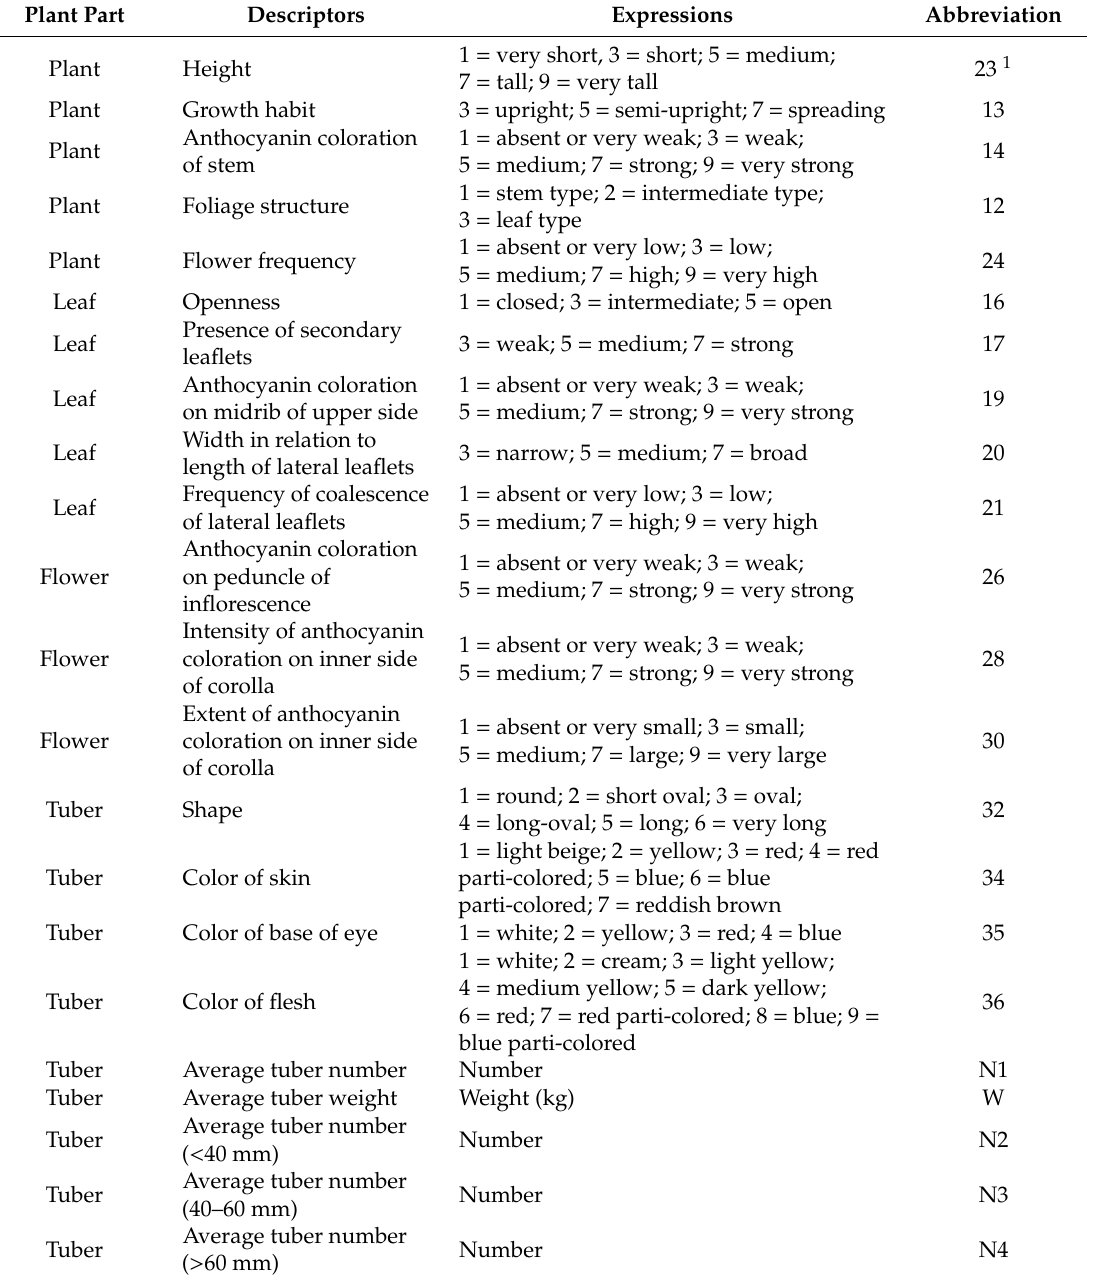
Table 1. List of the descriptors used in the morpho-agronomic characterization of the potato